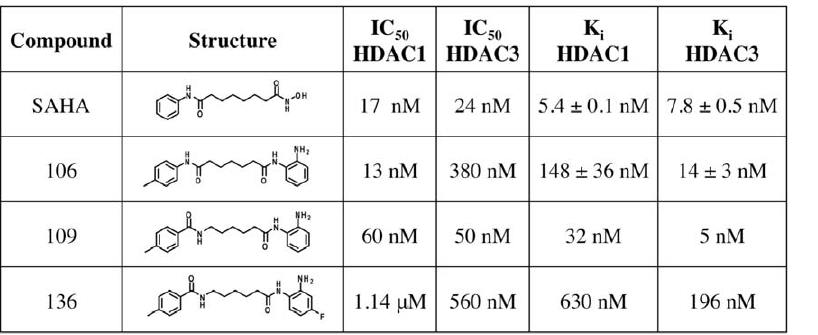
Figure 1. Structure and kinetic properties of histone deacetylase inhibitors. The structures of the new compounds 109 and 136 are shown, along with the structures of the previously described compound 106 [9] and of SAHA. For each compound, the IC 50 and K i for HDAC1 and HDAC3 are provided.